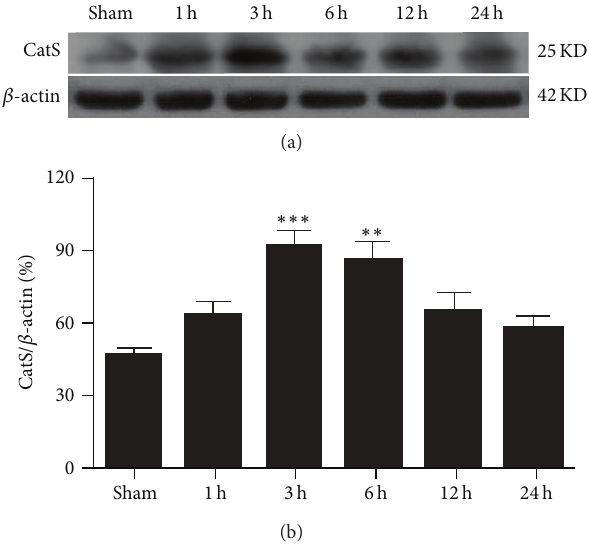
Table 1: Neurological severity score (NSS).